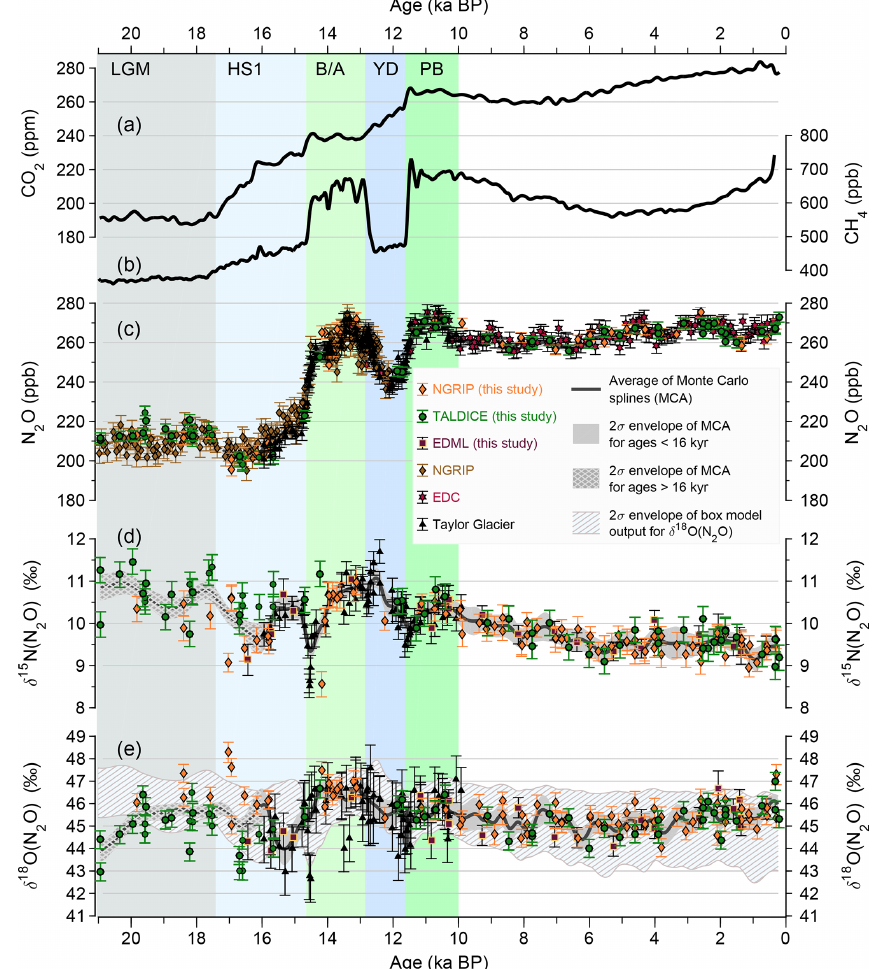
Figure 3. Greenhouse gas records over the last 21kyr after removing N 2 O samples affected by in situ formation. (a) CO 2 concentration compilation (Bereiter et al., 2015), (b) CH 4 concentration (Loulergue et al., 2008; Rhodes et al., 2015), (c) N 2 O concentration as compiled in this study, (d) δ 15 N(N 2 O) and (e) δ 18 O(N 2 O) from Schilt et al. (2014) and this study. The solid lines in (c) – (e) represent Monte Carlo Average smoothing splines with a cutoff period of 2000 years prior to 16kaBP and 700 years afterwards. The grey shaded envelopes represent the Monte Carlo based uncertainties ( ± 2 σ ) of the splines. The dashed envelope in panel (e) depicts the ± 2 σ range of the forward modeled atmospheric δ 18 O(N 2 O) signal expected from the terrestrial and marine emissions reconstructed using N 2 O concentrations and δ 15 N(N 2 O) (see also Fig.